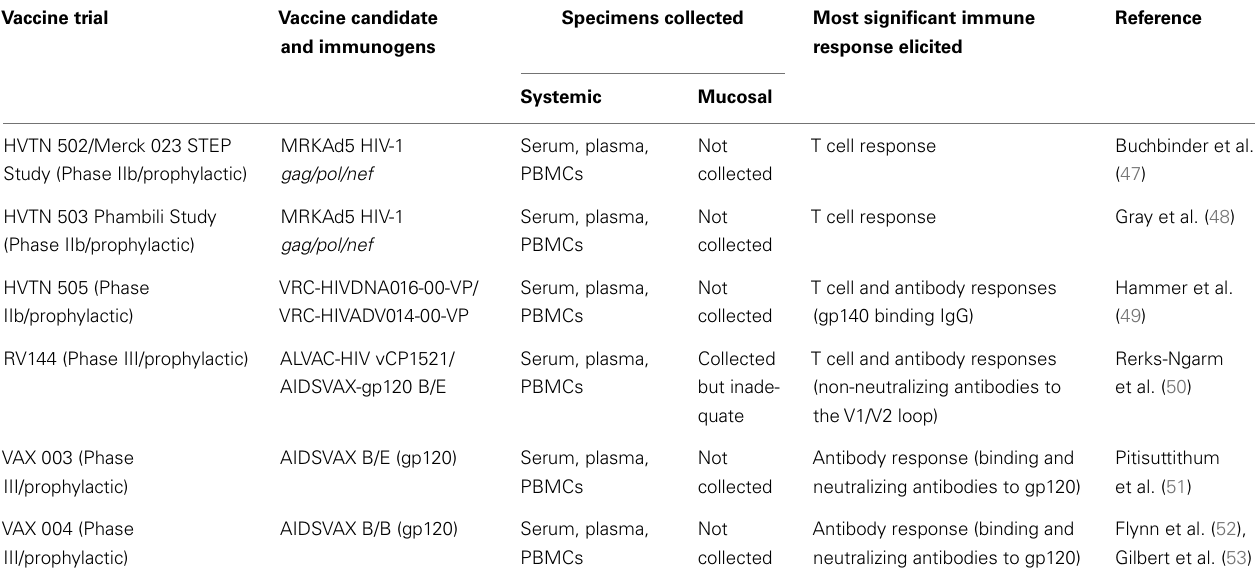
Table 1 | Phase IIb and III HIV vaccine efficacy trials